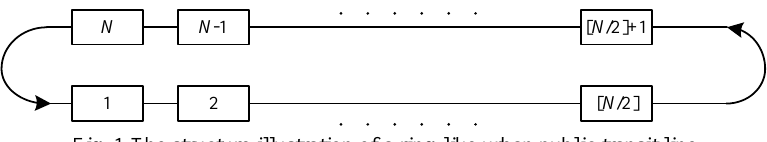
Fig. 1 The structure illustration of a ring-like urban public transit line